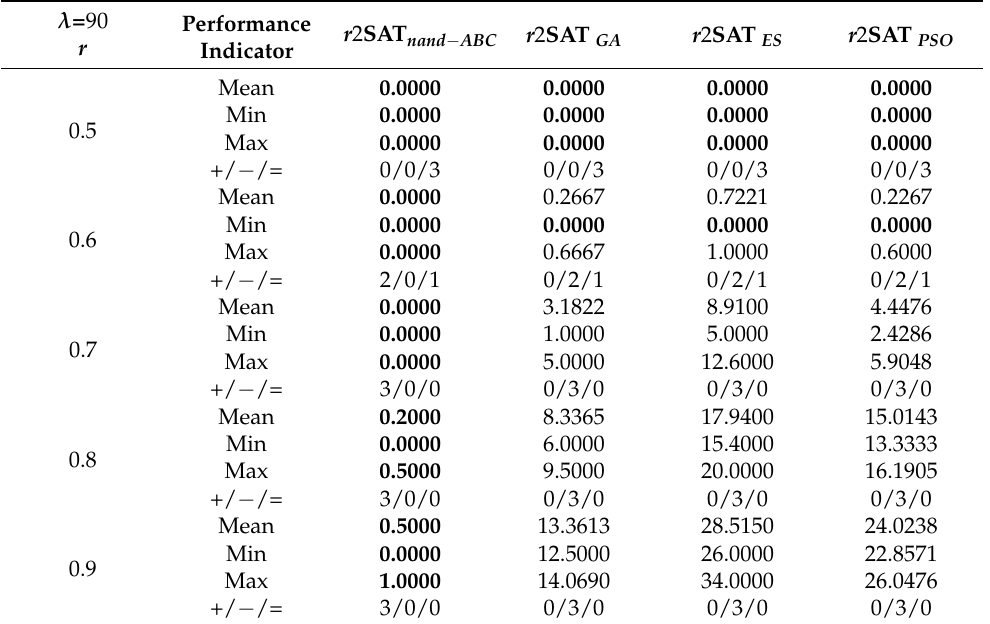
Table 18. Comparison of r 2SAT nand − ABC against other binary algorithms in terms of MAE for λ = 90. λ =